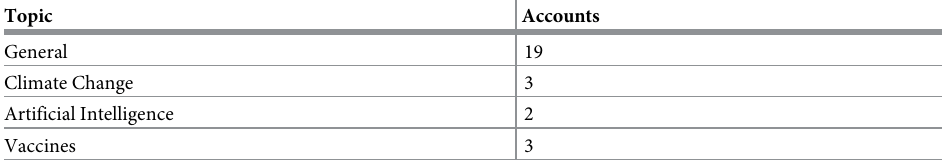
Table 1. Summary of the number of accounts involved in the experimental phase on social media by